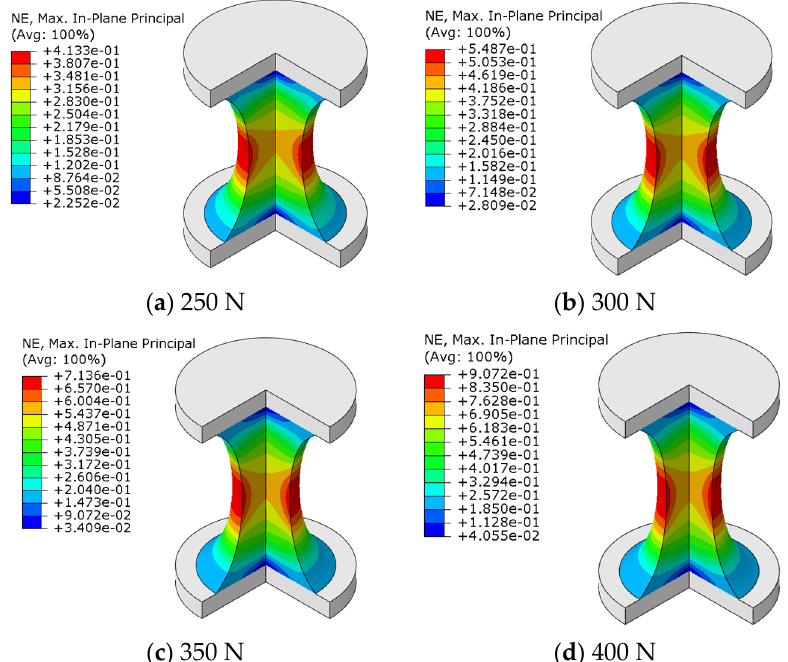
Figure 6. Maximum principal strain contours of the hourglass rubber specimen. ( a ) 250 N; ( b ) 300 N; ( c ) 350 N; ( d ) 400 N. Table 1. The maximum principal strains of the hourglass specimen loaded with different maximum forces.